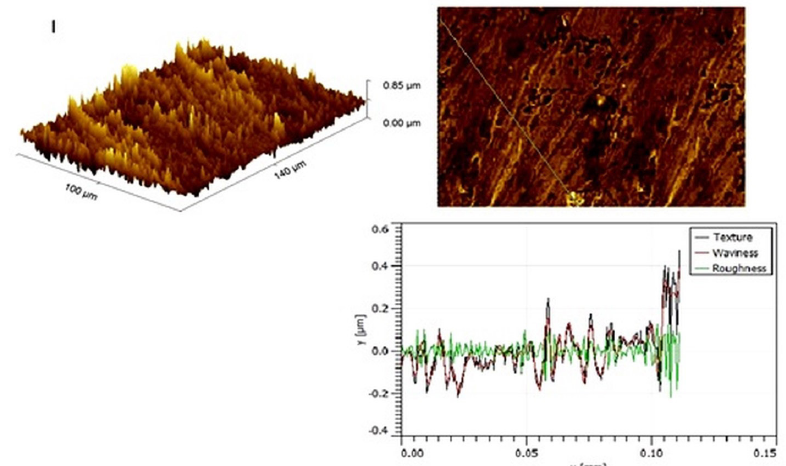
Figure 6. AFM images for the specimen1 (25N of Load, 400 rpm of disc speed, 9 m/sec of velocity and wear rate of 0.0587 mm 3 /min).